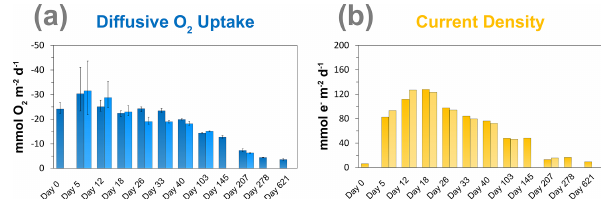
Figure 4. Time series of the (a) diffusive O 2 uptake in mmolO 2 m − 2 d − 1 and (b) current density as a consequence of long-distance electron transport ( e − ) in mmol e − m − 2 d − 1 in the sediment